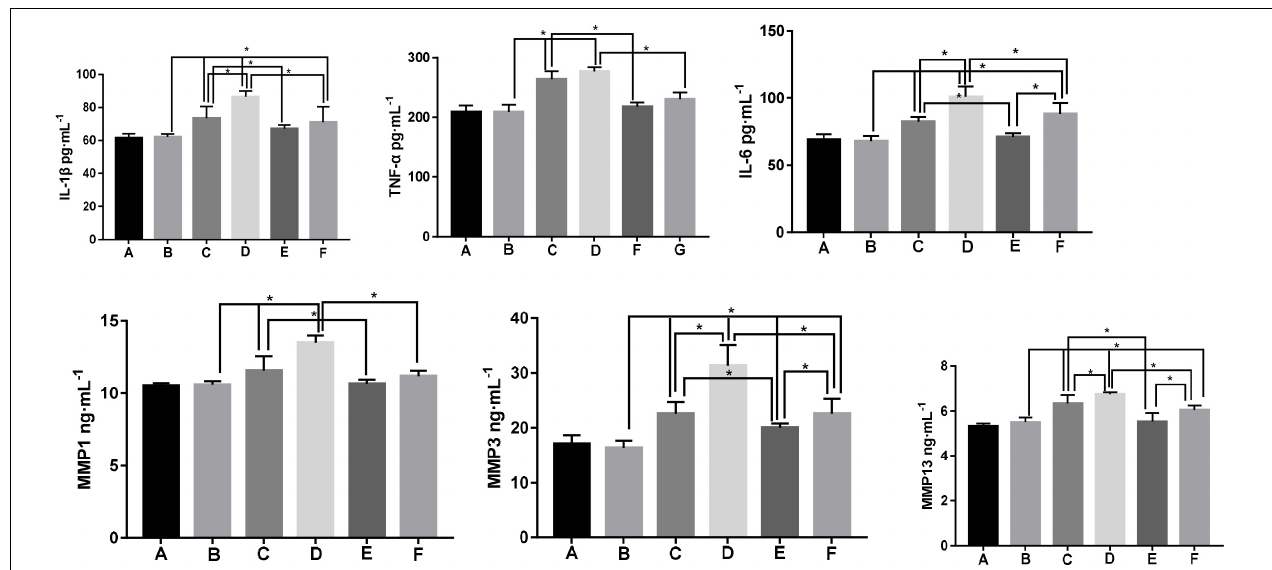
FIGURE 3 | The expression of TNF- α , IL-1 β , IL-6, MMP1, MMP3, and MMP13 in the serum of rabbits of each group. Note (A) Group B; (B) Group S; (C) Group M1; (D) Group M2; (E) Group EA1; and (F) Group EA2. * P < 0.05.